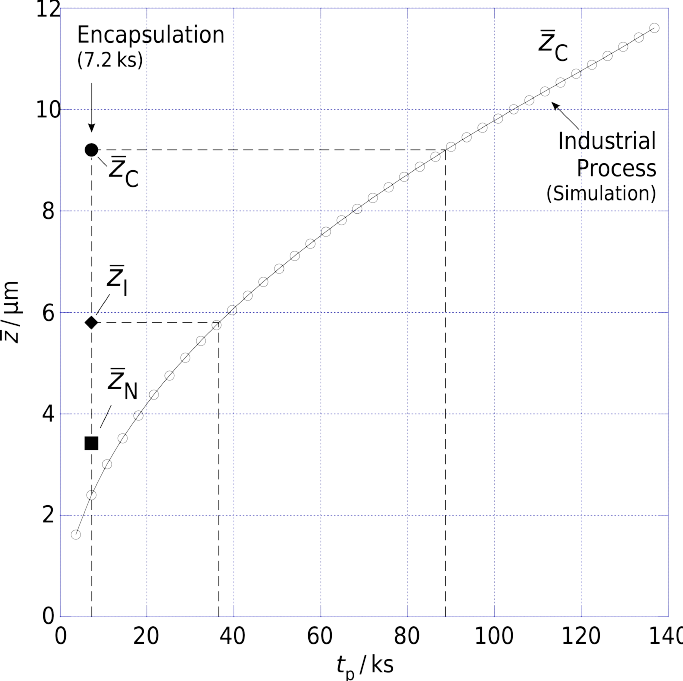
Figure 9. Mean depth of interstitial solute versus processing time t p . The solid data points marked by z N , z C , and z I refer to the Encapsulation Method, indicating the mean depth of nitrogen, carbon, and both interstitial solutes (nitrogen and carbon combined), respectively. The hollow circular data points, connected by a continuous line, show simulated z C data for the industrial process